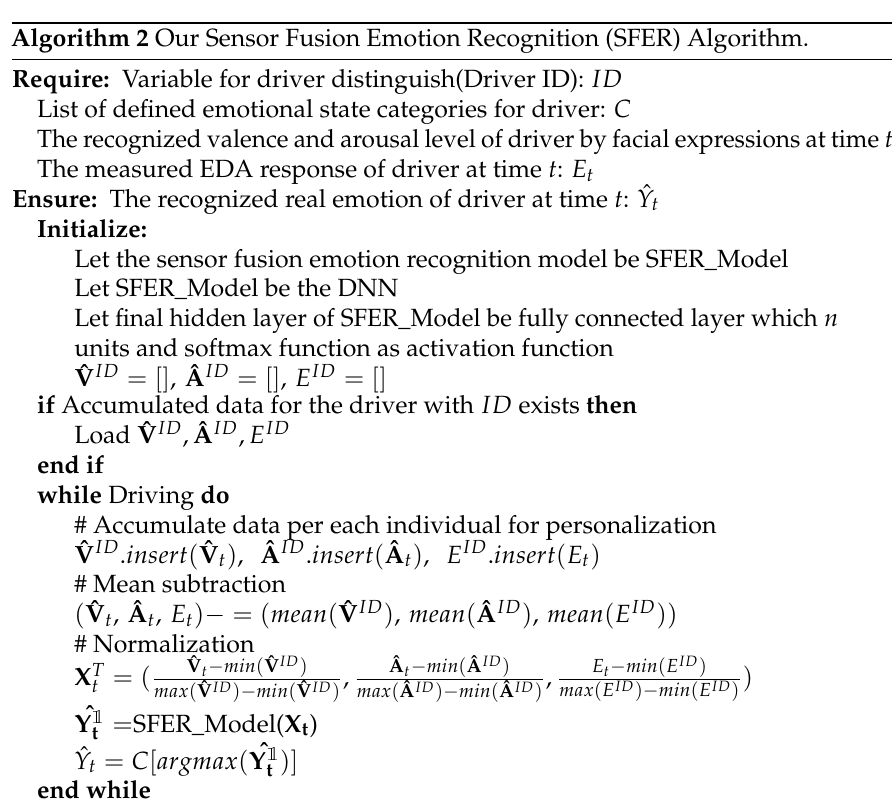
Algorithm 2 Our Sensor Fusion Emotion Recognition (SFER)